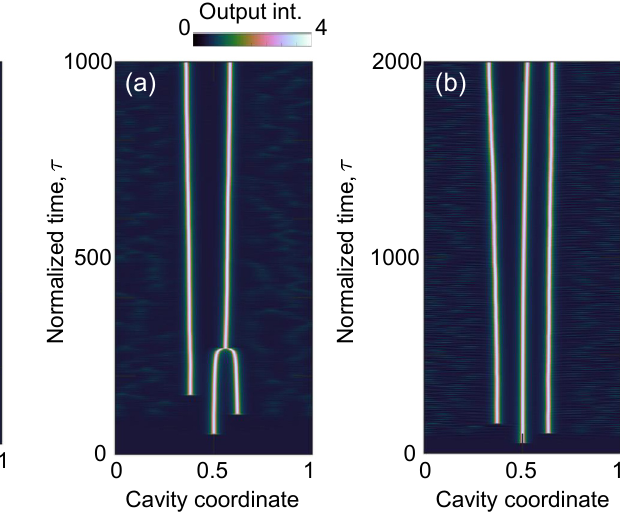
Figure 8: Y = 7. (a) A pulse is injected too close ( D = 0.16) to an existing cavity soliton (CS); the emission pro fi le is destabilized towards rolls. (b) The distance between the CS and two adjacent pulses is now D = 0.17, three independent CSs emerge at regime.